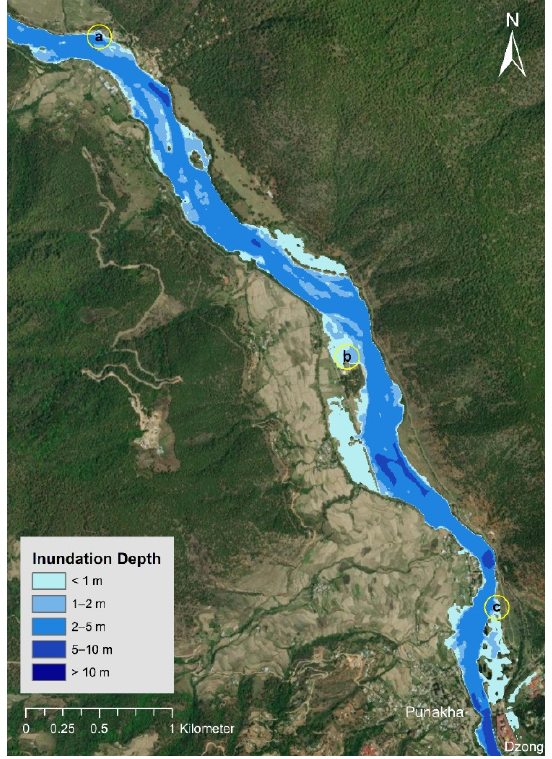
Figure 7. Maximum flood depth for the worst case scenario (see text for explanations) in Punakha, based on EM3D elevation data. Letters a–c (marked by yellow circles) indicate the location of affected buildings. Background map: World Imagery (Source: Esri, Maxar, Earthstar Geographics, USDA FSA, USGS, Aerogrid, IGN, IGP, and the GIS User Community).